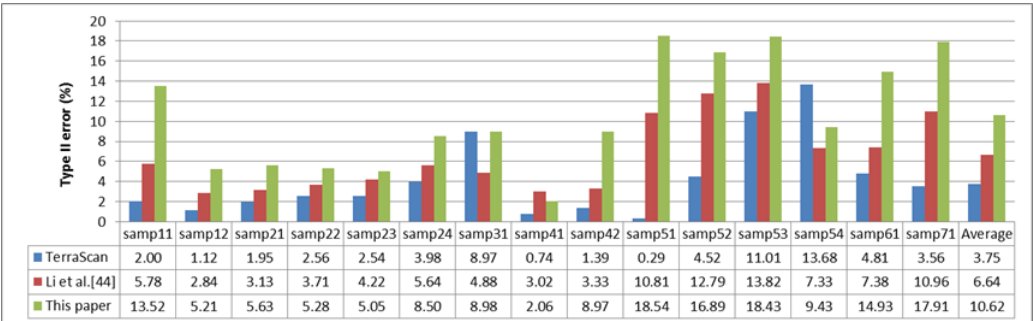
Figure 8. Comparison of type II errors for filtering ISPRS datasets.